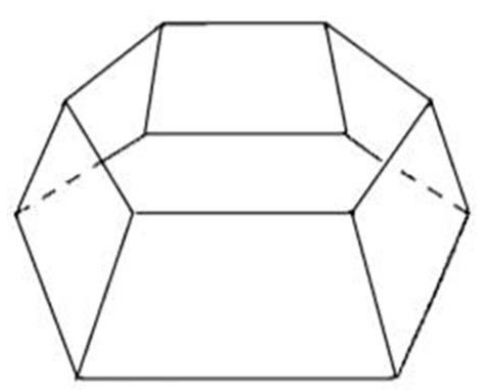
Figure 1: Hexagonal Shape Open Top Chamber. Adapted from Ulf Molau, Per